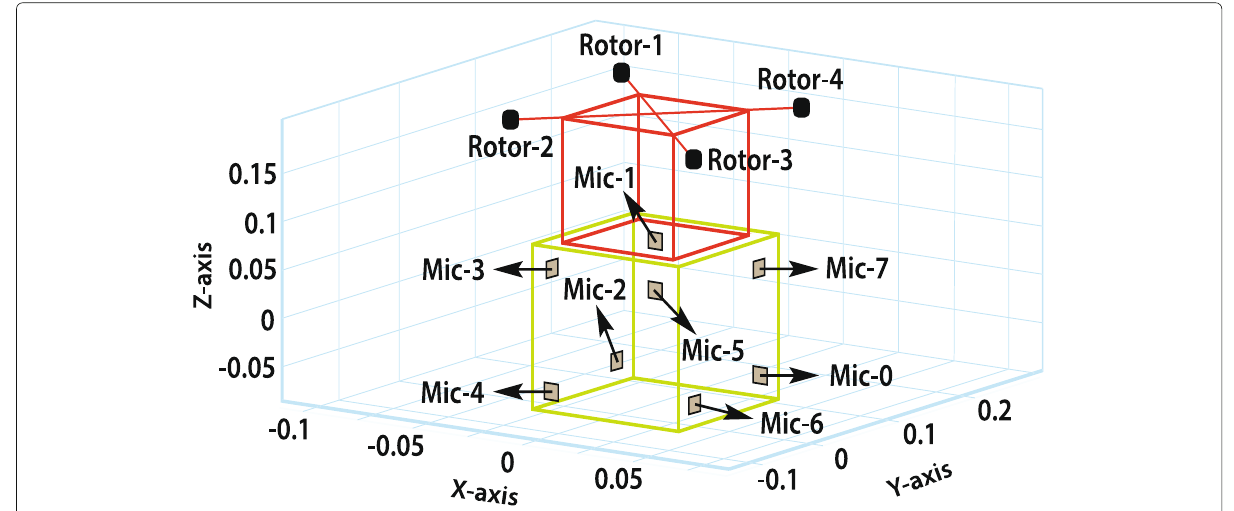
Fig. 2 Positional plot of all microphones and rotors (in